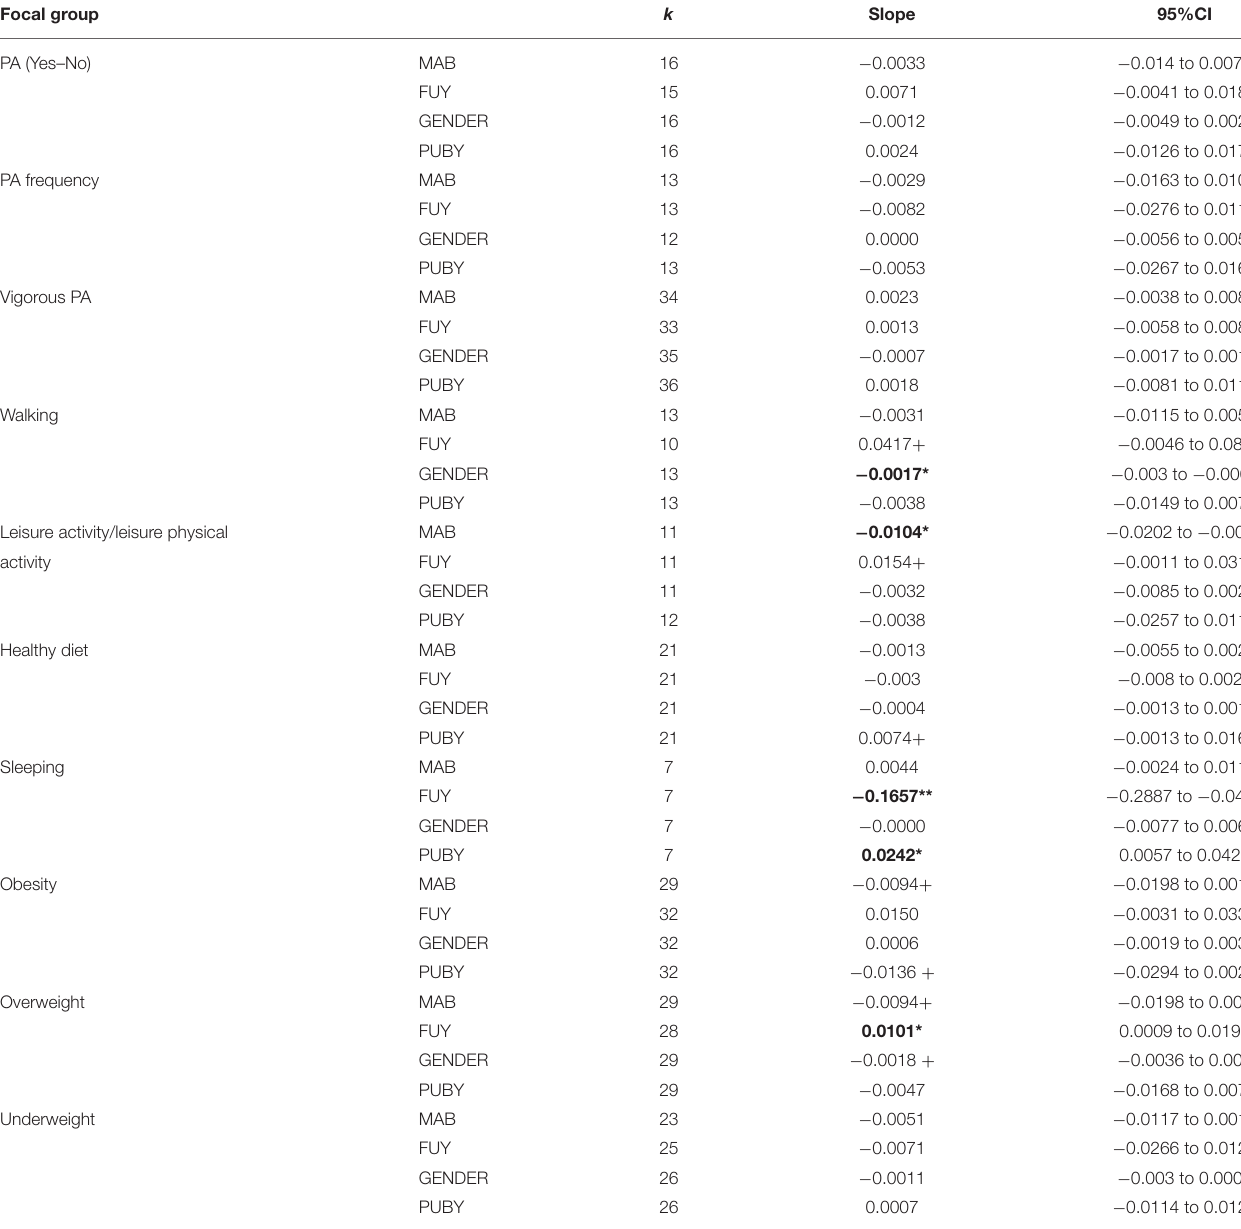
TABLE 3 | Results of meta-regression models on lifestyle factors. Focal